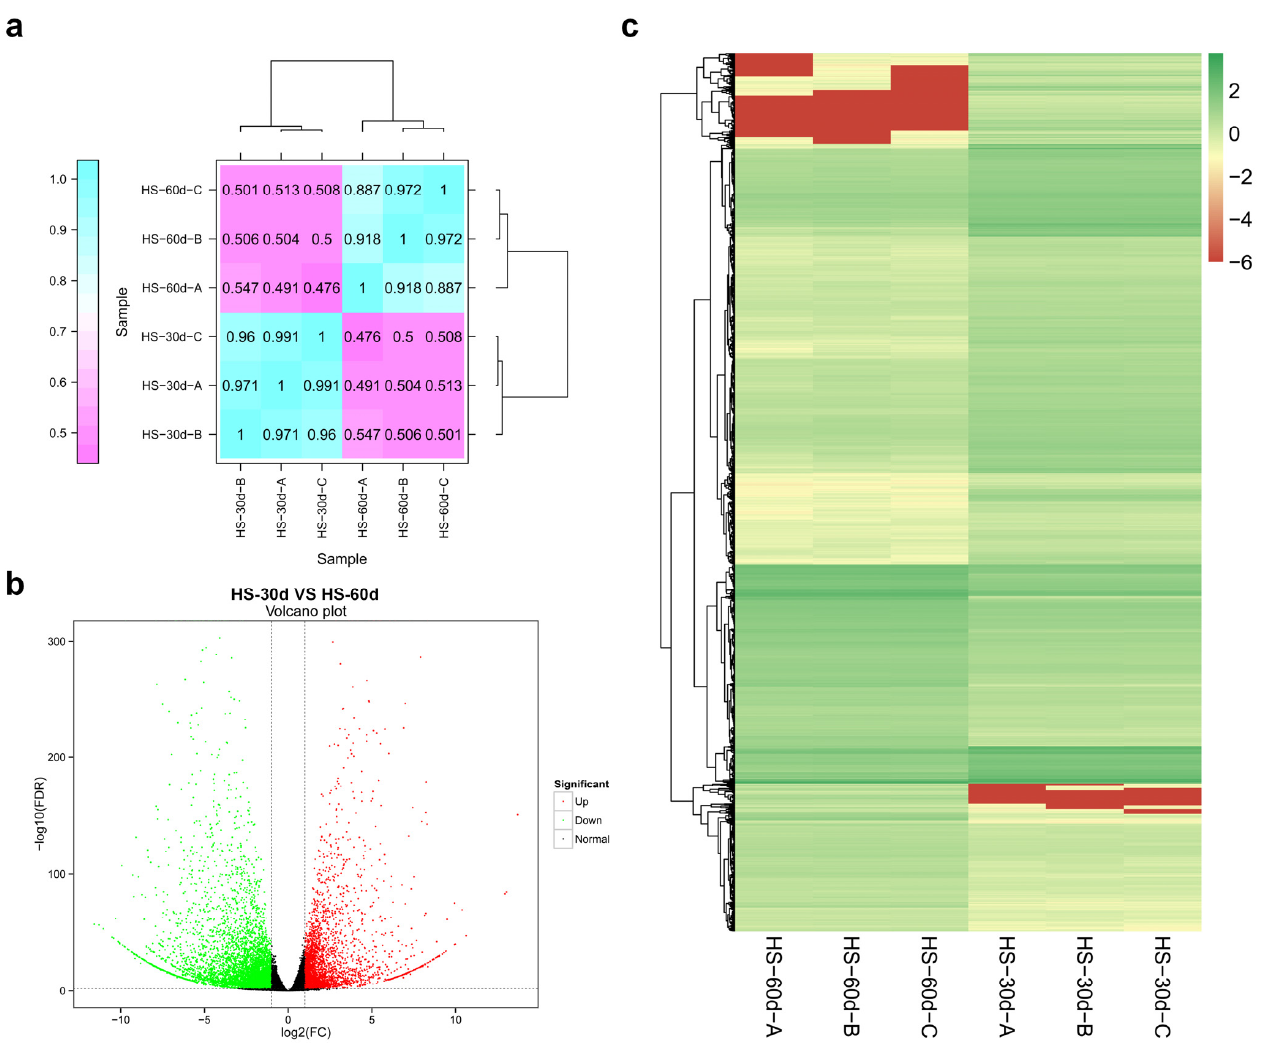
Figure 3. Transcriptome analysis of the DEGs in ‘Huashuo’ fruit flesh. ( a ) Correlation analysis be- tween the six samples (HS-30d, HS-60d, with three replicates). HS-30d: Huashuo fruit at 30DAFB; HS-60d: Huashuo fruit at 60DAFB. ( b ) Volcano plot analysis of DEGs in HS-30d vs. HS-60d. ( c ) Heatmap of the expression profiles of the DEGs identified in HS-30d vs. HS-60d. ( d ) COG annota- tion classification of DEGs. ( e ) KEGG enrichment analysis of DEGs.